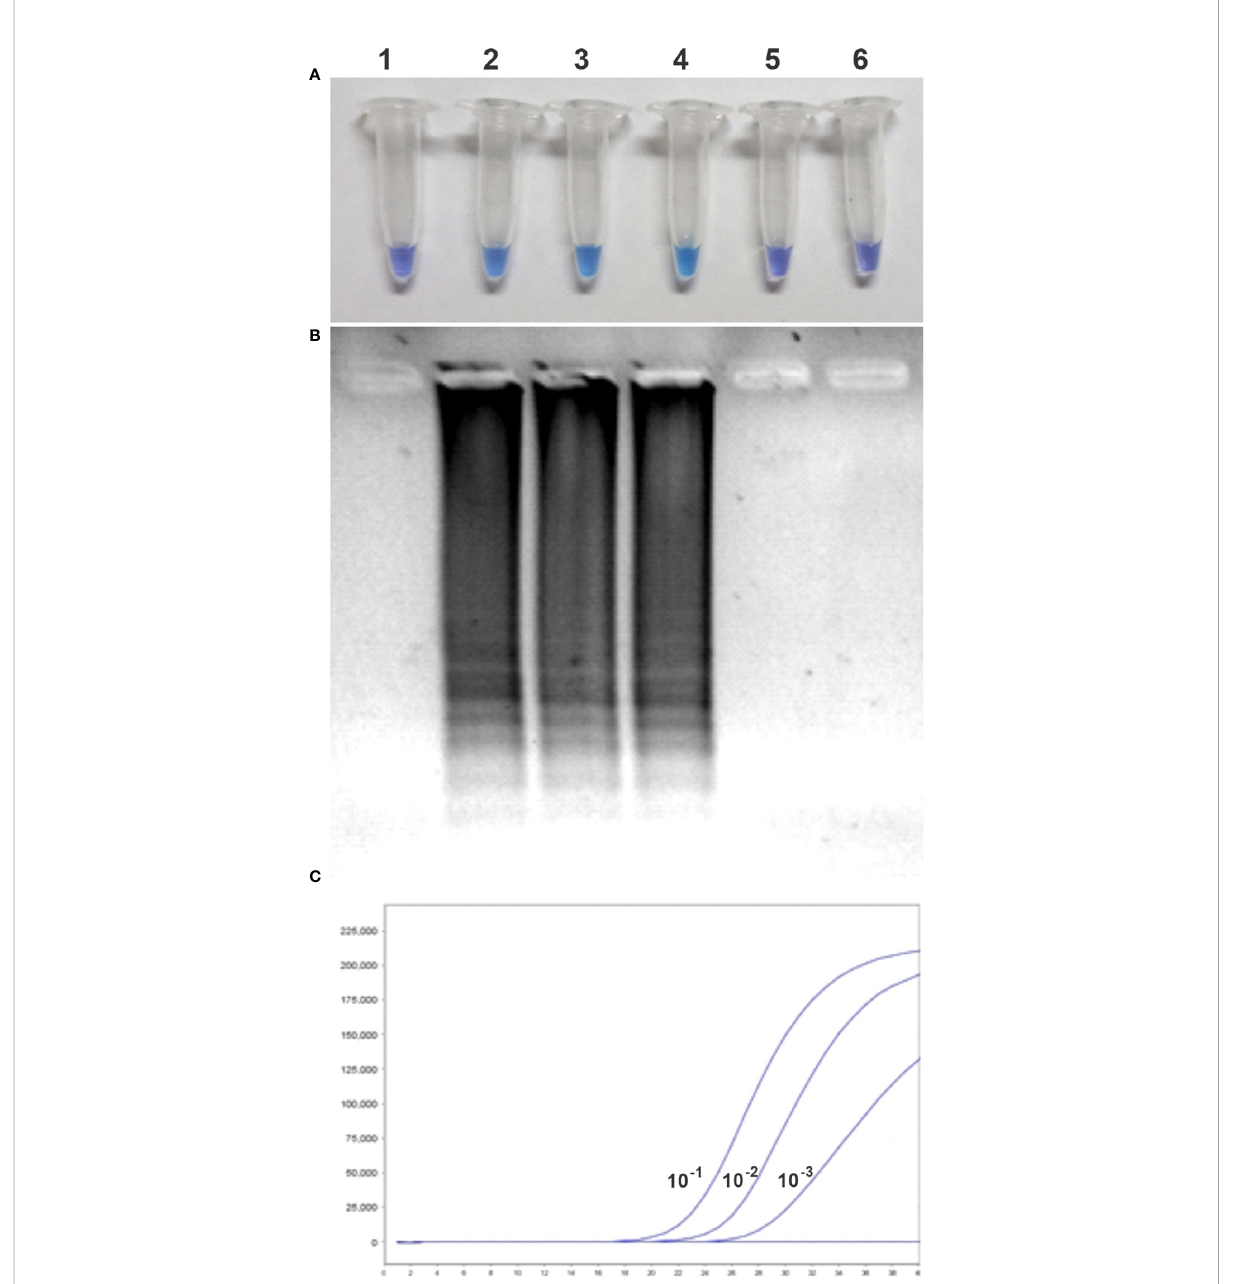
FIGURE 2 Comparative sensitivities between hydroxynaphthol blue (HNB) – loop-mediated isothermal ampli fi cation (LAMP) and qPCR for detecting HLB. (A) Visual examination of LAMP results. (B) Electrophoresis analysis of LAMP products on 1.5% (p/v) agarose gel. (C) Sensitivity of real-time PCR for detecting HLB. Lanes 1 – 6, negative control and serially diluted genomic DNA (10 − 1 , 10 − 2 , 10 − 3 , 10 − 4 and 10 − 5